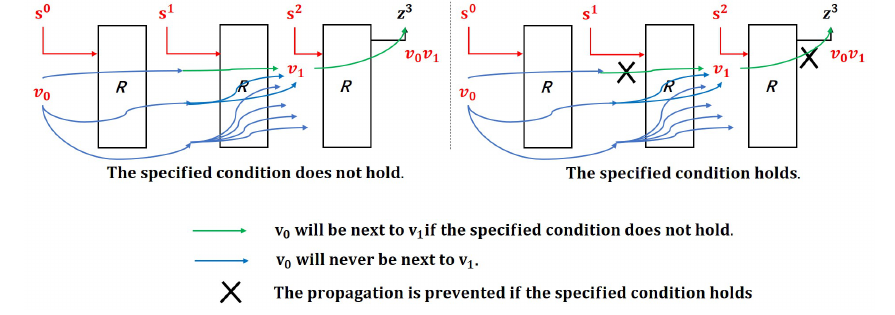
Figure 7: Illustration of TYPE-IV conditional cube